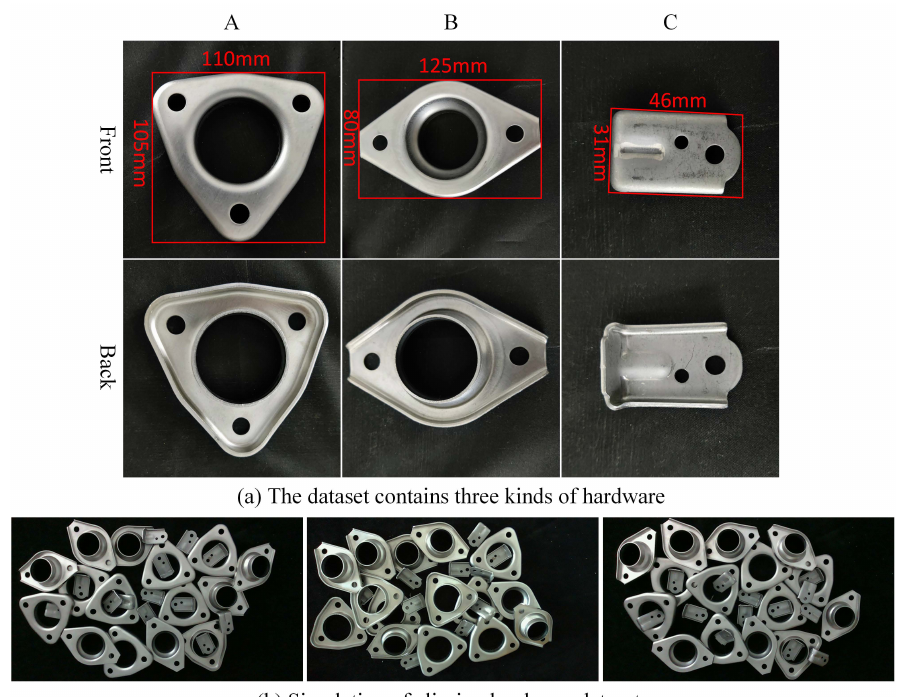
Figure 7. Dataset